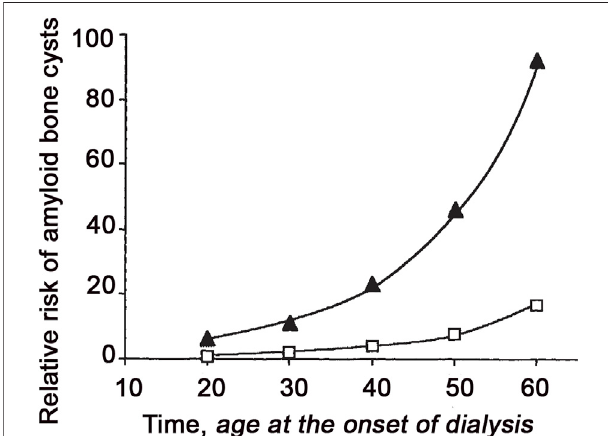
FIGURE 3 | Relative risk of bone lesions by amyloid deposition as a function of age at the initiation of dialysis either on AN69 or a cellulosic membrane. The risk of developing the lesion with AN69 for patients starting at age 20 is assumed to be one. Data are based on the best fi tted model provided by Van Ypersele de Strihou work (de Strihou et al., 1991). Reprinted from (de Strihou et al., 1991) with permission from Elsevier, Copyright